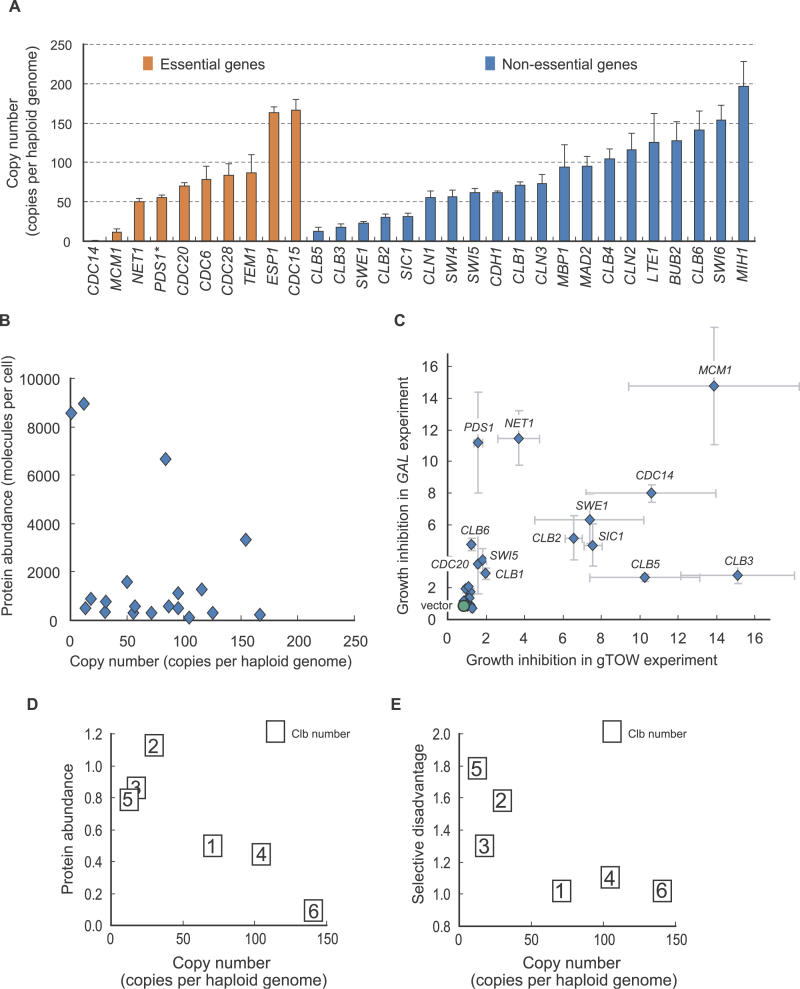
Comparisons of the Data Obtained in the gTOW Experiment with Other Qualitative and Quantitative Datasets(A) The plasmid copy numbers in the gTOW experiment with essential genes and nonessential genes [9,41].(B) A scatter plot between protein abundance obtained by Ghaemmaghami et al. [26] and the plasmid copy number in the gTOW experiment.(C) A scatter plot of growth inhibitions between the GAL experiment and gTOW experiment with the 30 CDC genes.(D) A scatter plot between protein abundance determined by Cross et al. [21] and the plasmid copy number of B-type cyclins in the gTOW experiment. The protein abundance is the number of copies per log-phase yeast cell of the indicated cyclin protein C-terminally tagged with protein A expressed from the endogenous promoter and chromosomal location [21].(E) A scatter plot between selectable disadvantage determined by Cross et al. [21] and the plasmid copy number of B-type cyclins in the gTOW experiment. The selective disadvantage parameter reflects differences in doubling time between wild-type and mutant cells. The data used in the graphs are listed in Tables S1, S2, and S3.